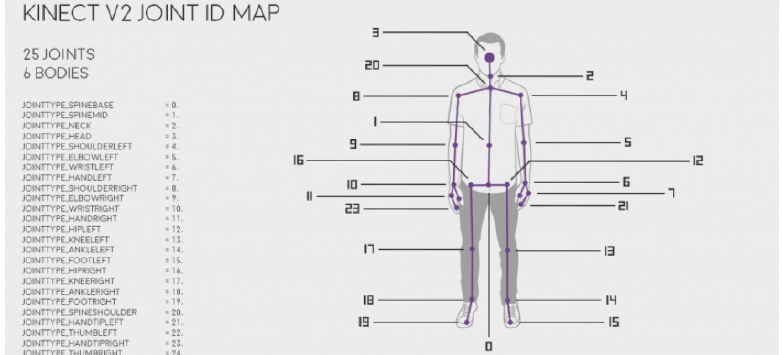
Figure 5. A list of body joints captured by Kinect. For each joint, position and rotation values are stored in XML format (source: